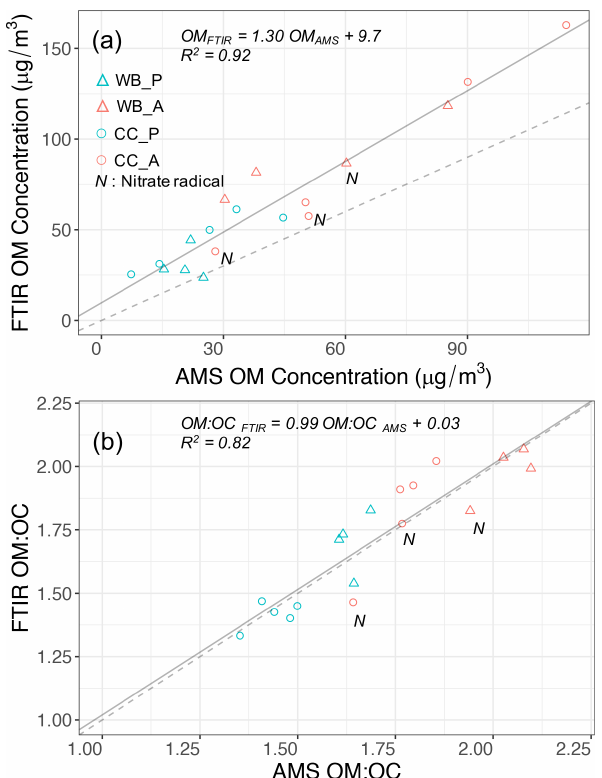
Figure 3. Scatter plot comparing OM concentration (a) and OM : OC (b) estimates by AMS and MIR for primary (P) and aged (A) aerosols of wood burning (WB) and coal combustion (CC). The fit- ted and 1 : 1 lines are solid and dashed,